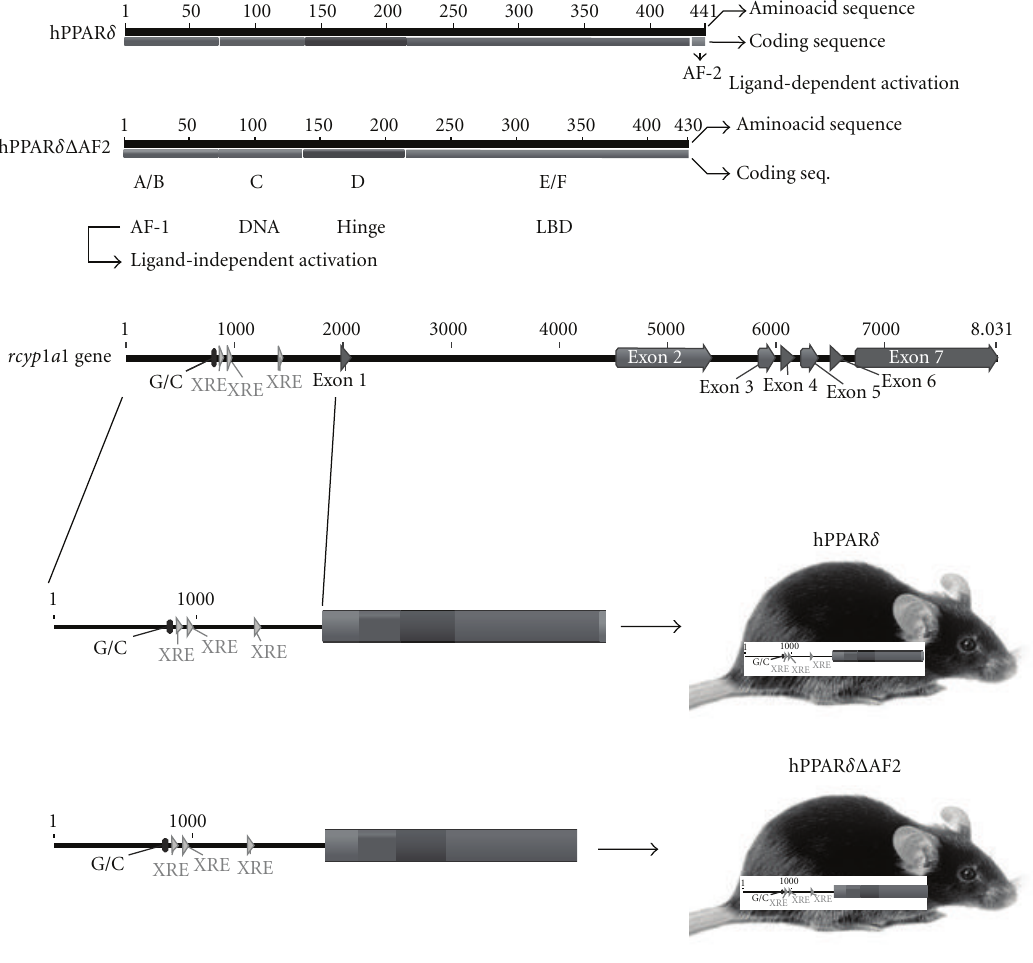
Figure 1: Graphic depicting the generation of mice conditionally expressing hPPAR δ and hPPAR δ Δ AF2 transgenes. Mice harbouring transgenes, encoding the coding sequence of hPPAR δ or hPPAR δ Δ AF2 fused to the rat Cyp1a1 gene promoter and o ff ering tight control of XRE enhancer driven transgene